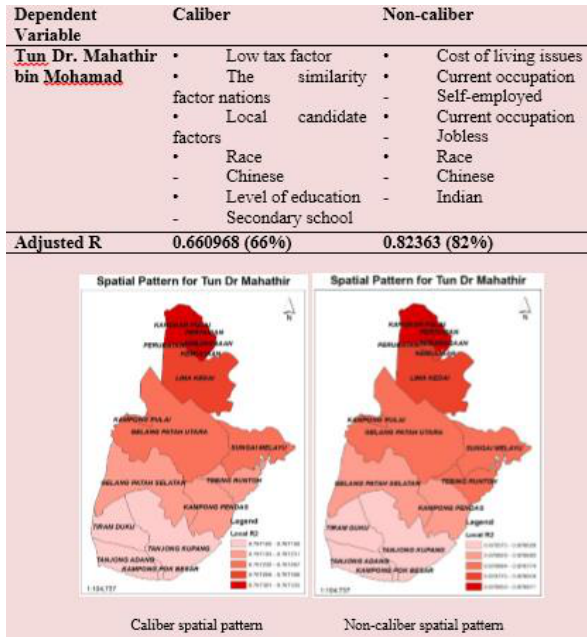
Figure 21. Explanatory variable for Tun Dr. Mahathir Mohamad